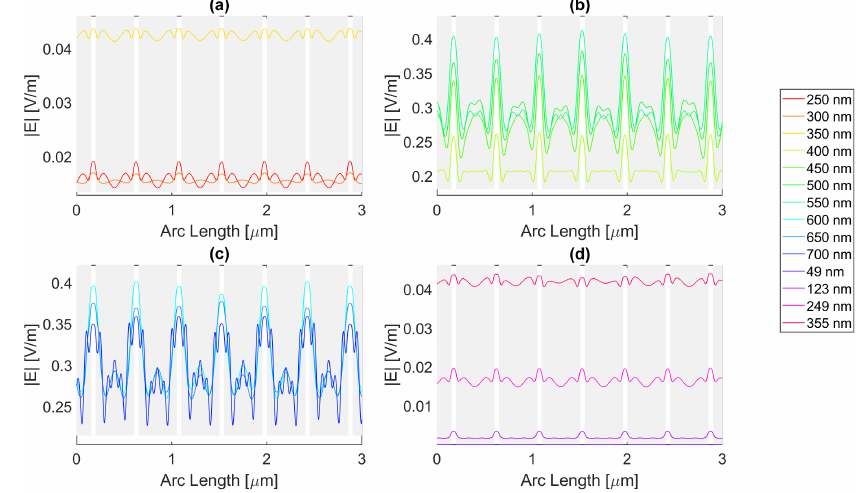
Figure 4. Electric field for silver 20-nm-thick rectangular nanostructure—Probe